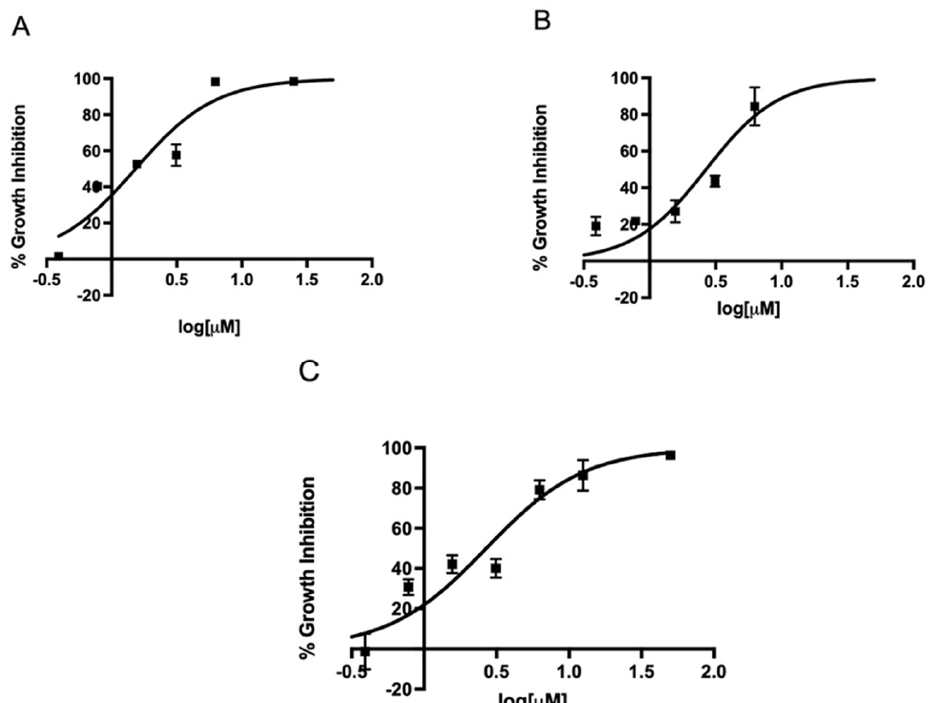
Figure 3. Concentration-dependent inhibition of growth of H. pylori by fexinidazole. Strains SS1 ( A ), 60190 ( B ), and G27 ( C ) were treated with different concentrations of fexinidazole for 24 h and EC 50 curves were generated from mean values of percentage growth inhibition ± SEM of fexinidazole against H. pylori .